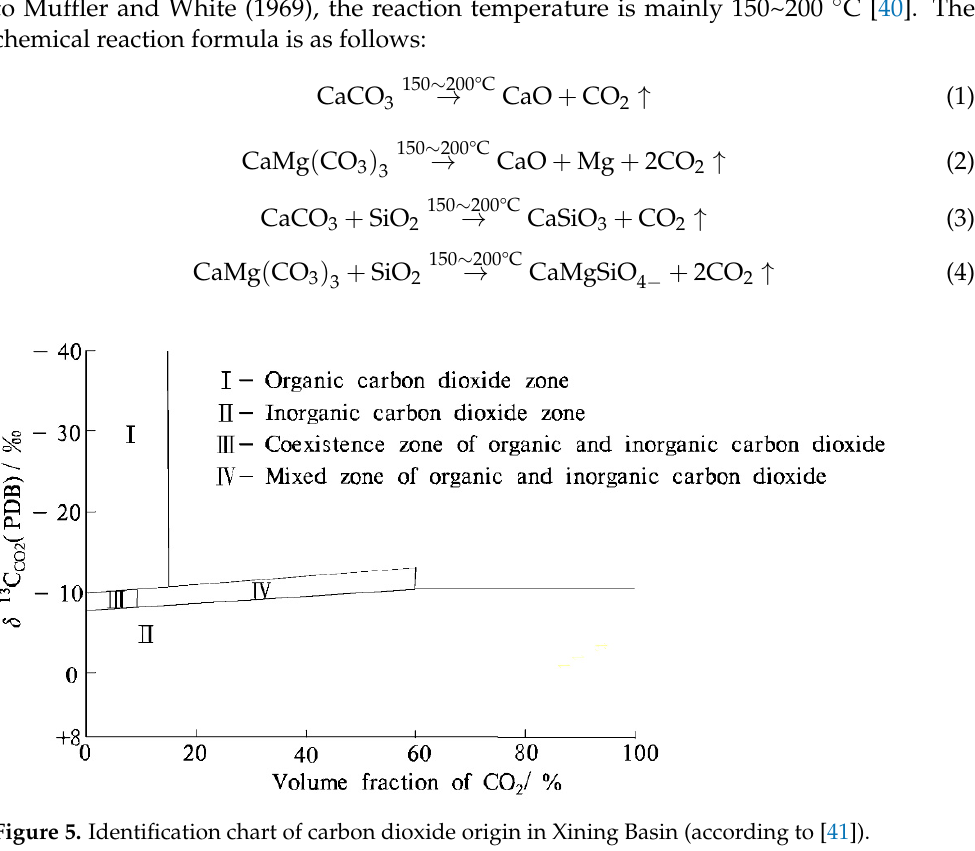
with secondary calcite [34], which indicates that the carbonated thermal water spring trav- ertine in the Qijiachuan may be formed in the deep geological environment with a tem- perature of 150–200 ℃ . The CO 2 formed during the metamorphism of deep carbonates and silicates under high temperature and pressure migrates along the surface of the Laji Mountain fault zone and its secondary faults or the faults where it intersects, forming weakly acidic carbonated thermal water spring [43]. Weak acidity enhances the solubility